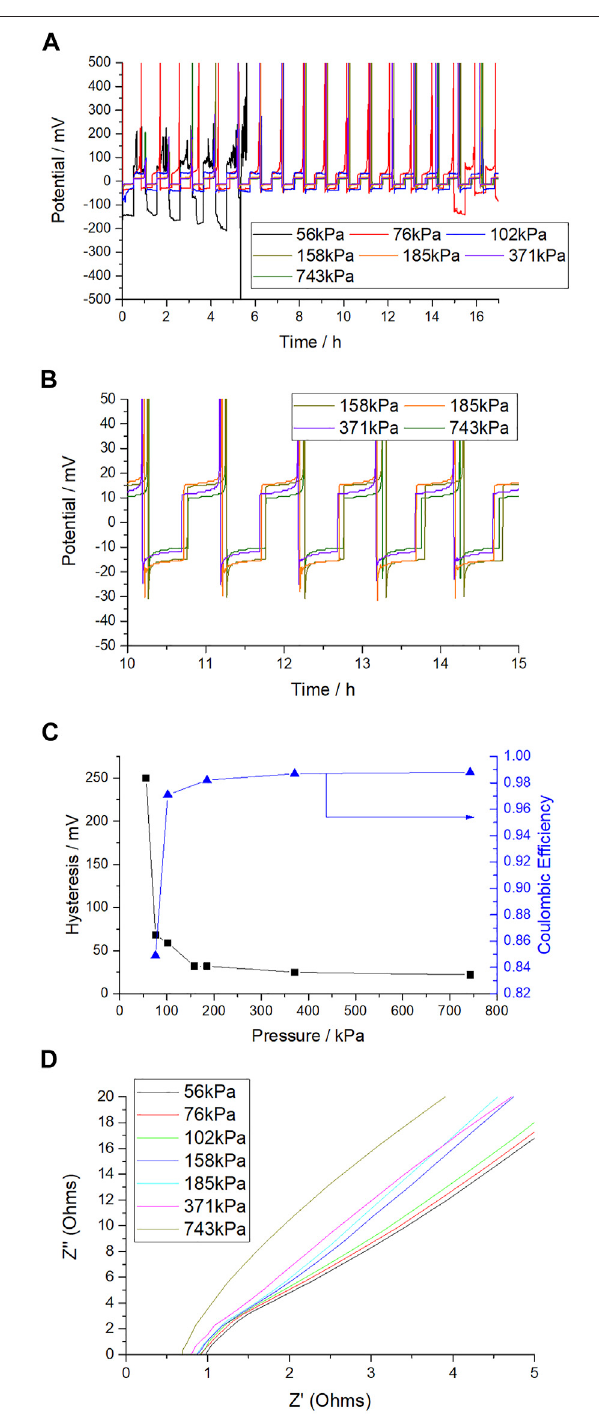
FIGURE 4 | (A) Voltage-time graph of Na||Cu half cells in split pouch cell format with increasing applied pressure (spacer thickness fi xed at 4 mm), 0.5 mA cm − 2 /0.25 mAh cm − 2 . (B) as previous but focusing on pressures > 185 kPa only. (C) Hysteresis (and coulombic ef fi ciency) vs. initial applied pressure. (D) As assembled EIS on increasing pressure. (10 mV perturbation, high frequency range from 40 to 1 khz